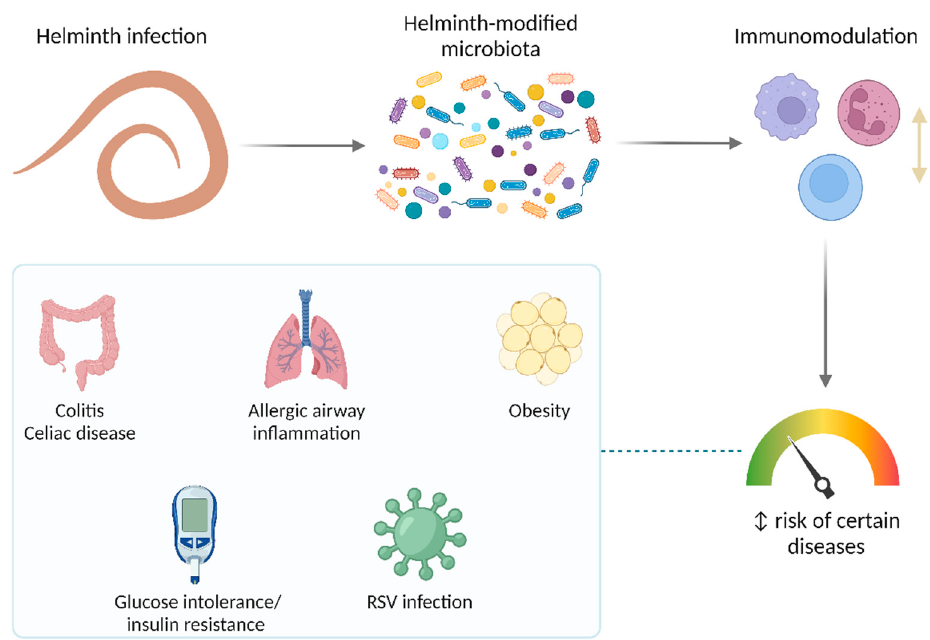
Figure 4. Impact of helminth-induced microbiota modifications on the risk of certain diseases. Helminth infections can modify the risk of some diseases; in most cases, reducing it. A microbiota-mediated regulation of the immune response is thought to be a key player. RSV, respiratory syncytial virus.